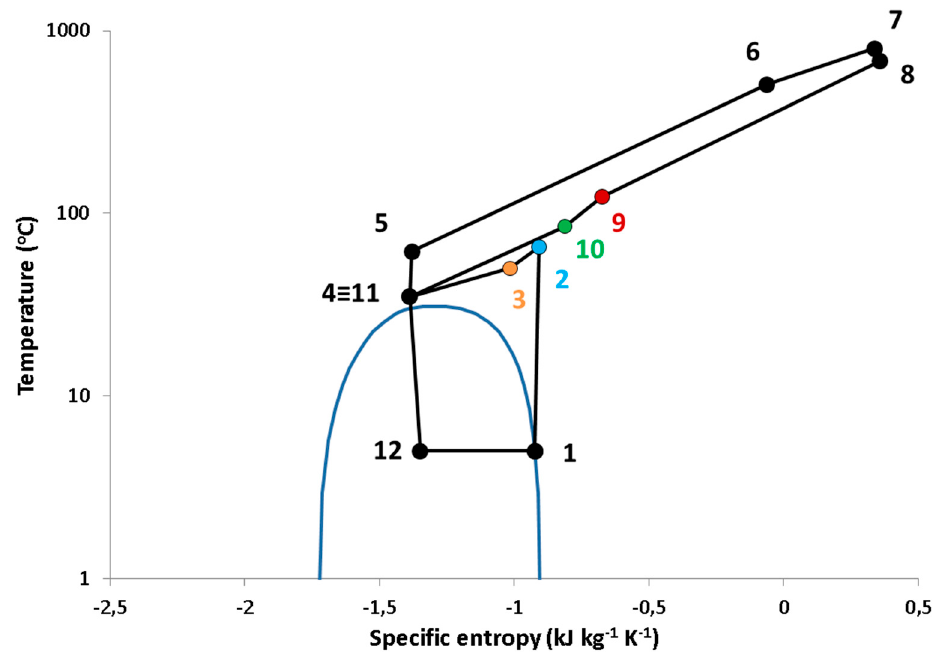
Figure 2. Pressure-specific enthalpy (p-h) diagram for the examined polygeneration system in nominal operating conditions.